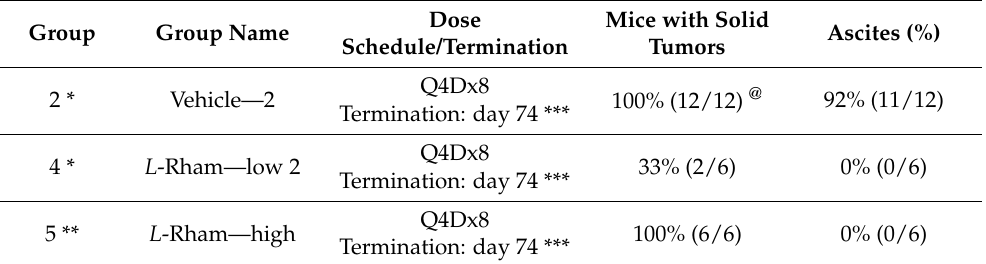
Table 1. Summary of L -Rham efficacy on OVCAR3 i.p. xenograft in NRG